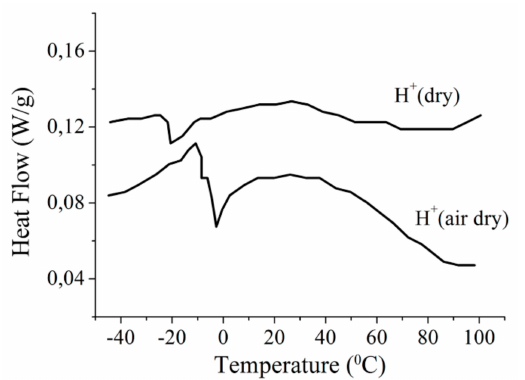
Figure 18. DSC thermograms in H + ionic forms of perfluorinated sulfo cation exchange MF-4SC membrane, which is complete analog of Nafion. Dry–sample was dried to constant weight at 120 ◦ C ( λ is about 2 water molecules per sulfonate group), air dry–sample was dried to constant weight at room temperature ( λ is about 5 water molecules per sulfonate group). Reprinted with permission from [38]. Copyright 2003 Springer